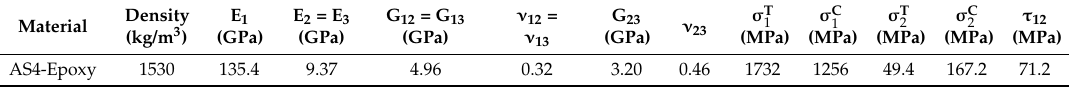
Figure 2. Lamina co ‐ ordinate system.